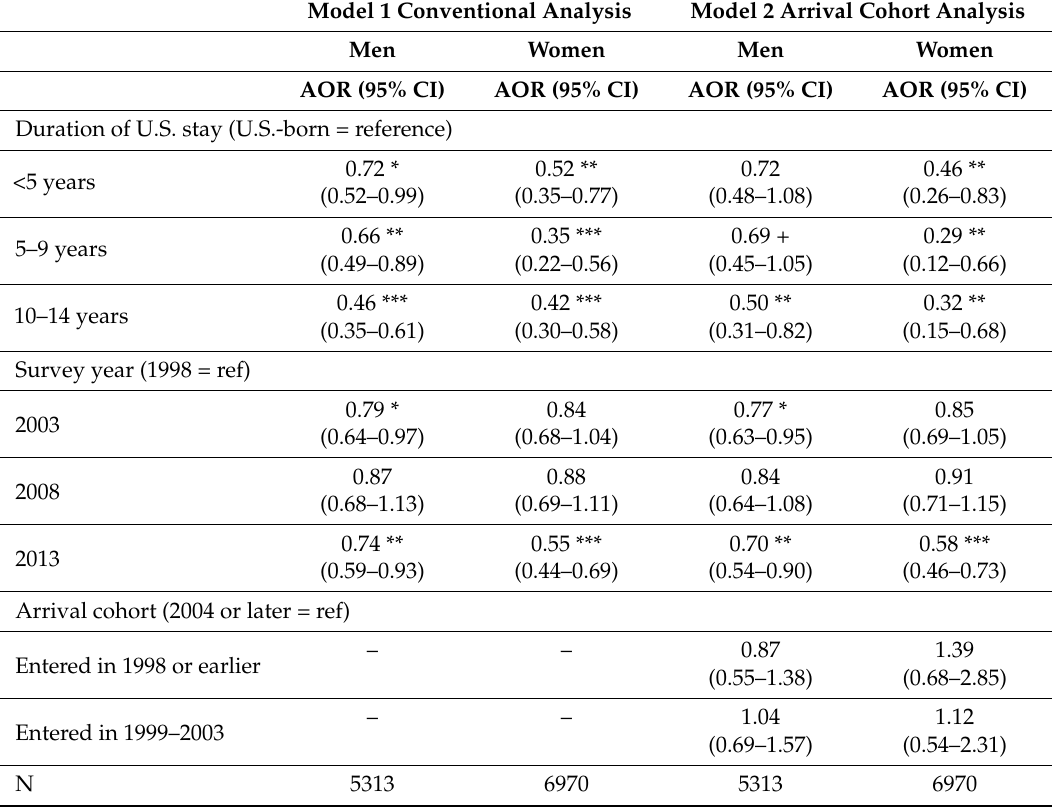
Logistic regressions predicting current smoking among Latinos by gender: Cross-sectional